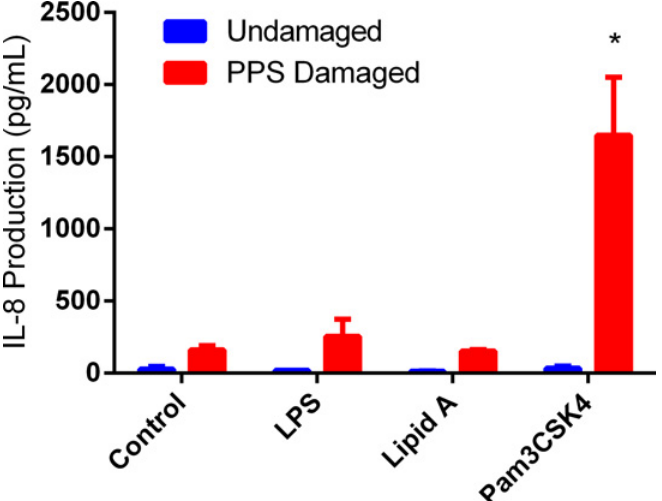
Fig 5. Translocation of Test Antigens Across Damaged Co-Culture Monolayers. Each test antigen was added to the apical compartment of undamaged and PPS damaged C2BBe1 co-cultures. LPS, Lipid A, and Pam3CSK4 were added at 10 ng/mL, 200 ng/mL, and 10 ng/mL, respectively. Pam3CSK4 was the only antigen tested capable of translocating a PPS-damaged barrier and stimulating IL-8 production by basal THP-1 monocytes. The small increases in IL-8 production observed for both LPS and Lipid A added to the apical compartment were not statistically different from PPS alone indicating these antigens were unable to translocate the PPS damaged barrier. * indicates P < 0.05, when comparing PPS-treated controls with varying antigen treatments.